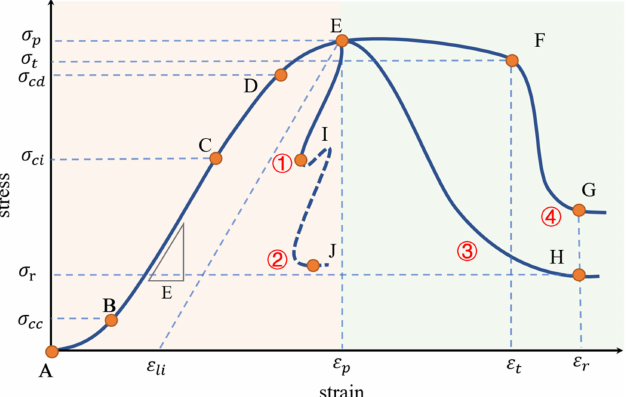
Figure 1. Stress–strain curves of different rocks. Note: σ cc is the initial crack closure stress, σ ci is the crack initiation stress, σ cd is the crack damage stress, σ p is the peak stress, σ t is the drop stress, σ r is the residual stress, ε li is the unrecoverable plastic deformation, ε p is the peak strain, ε t is the drop strain, and ε r is the residual